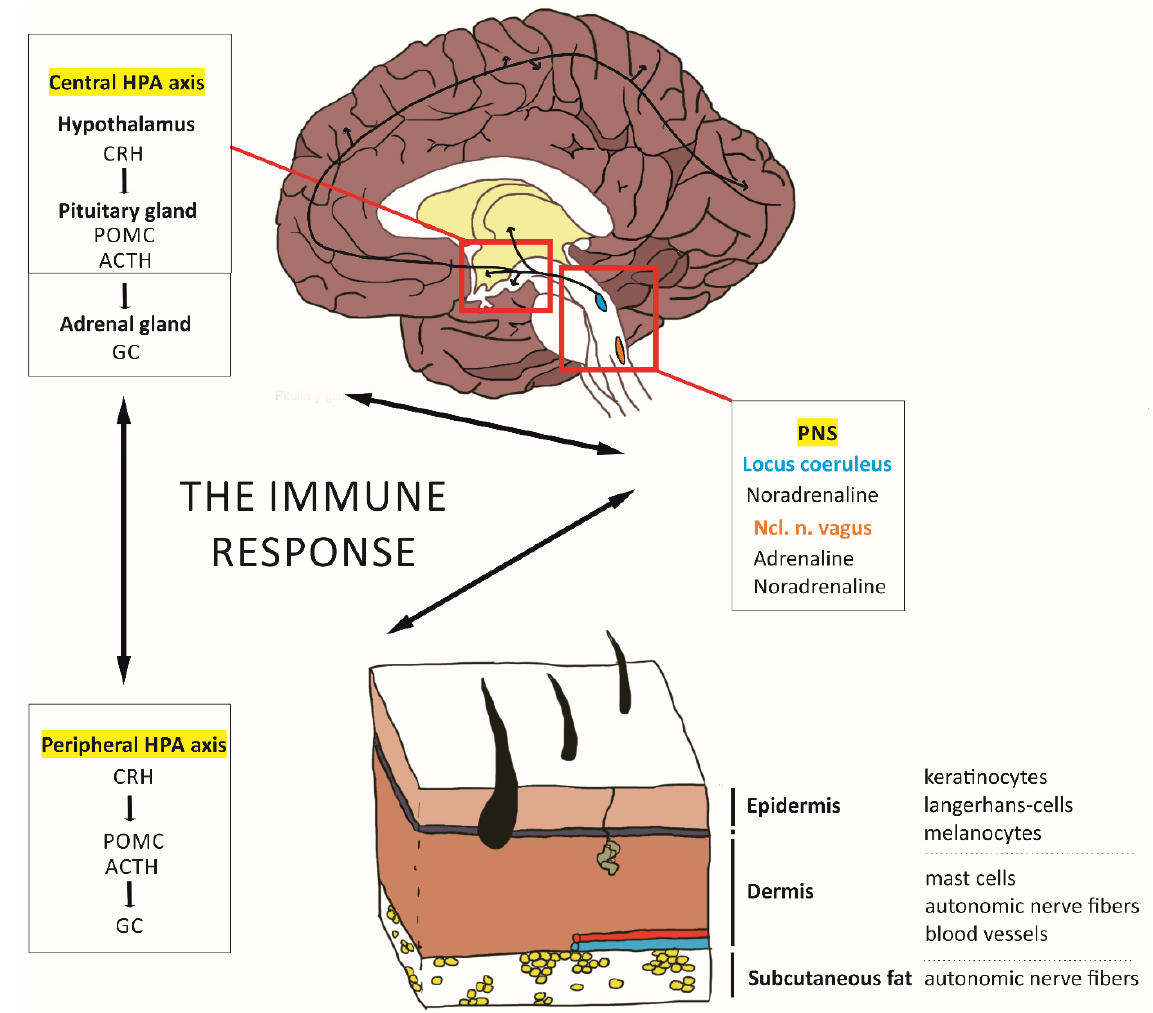
Figure 1. An immune response requires the interaction of the central HPA axis, another peripheral HPA axis, and the PNS. The central HPA axis reacts to stressors with the release of CRH from the paraventricular nucleus of the hypothalamus, which in turn leads to the secretion of POMC and ACTH from the pituitary gland. ACTH subsequently induces an increase in GC levels in the adrenal gland. Correspondingly, the peripheral HPA axis of the skin enacts a similar cascade. CRH is released from nerve fibers, or cells of the skin and leads to a release of POMC and ACTH, which again results in elevated GC levels. In principle, three different cell types of the skin play a major role for the immune response. These include keratinocytes and melanocytes, which reside in the epidermis, and mast cells, which are located in the dermis. Their differentiation and proliferation status are tightly regulated by CRH; however, disturbances in the HPA axis and, thus, CRH levels can easily lead to crucial changes in cell fate. Both the central and peripheral HPA axis are input and respond to the PNS. Most notably, the locus coeruleus is a main source of noradrenaline and exerts its influence on the limbic system as well as the mPFC and the ACC. In addition, the Ncl. n. vagus of the brainstem controls the release of adrenaline and noradrenaline in response to stressors.